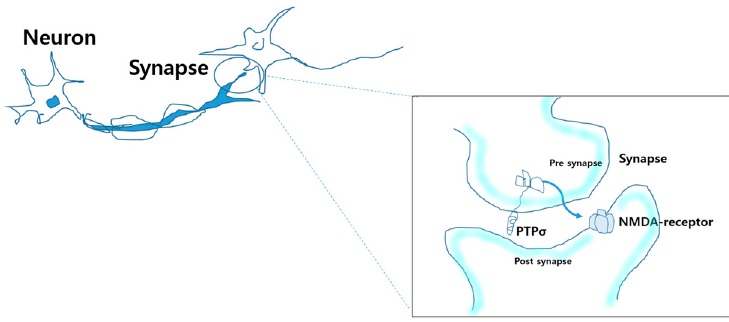
Figure 3. Neuron and Synapse of Neural Network in Human Brain.